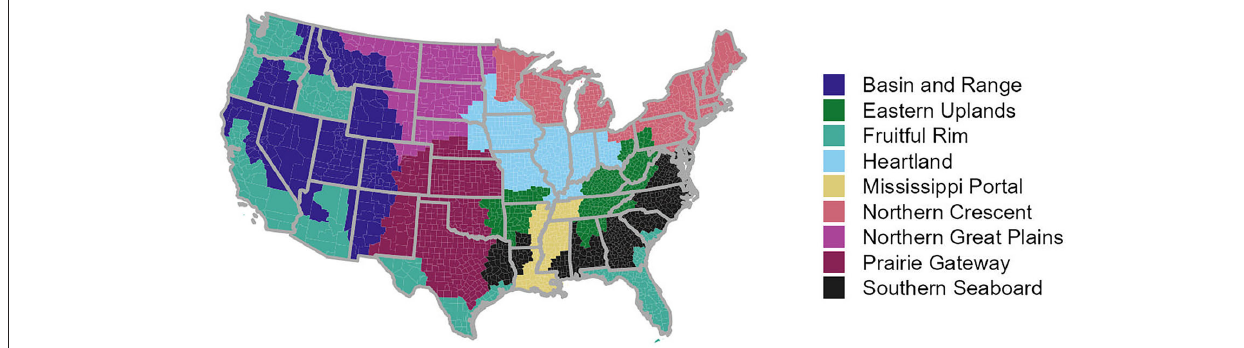
FIGURE 1 | The nine US Farm Resource Regions delineated by the USDA ERS